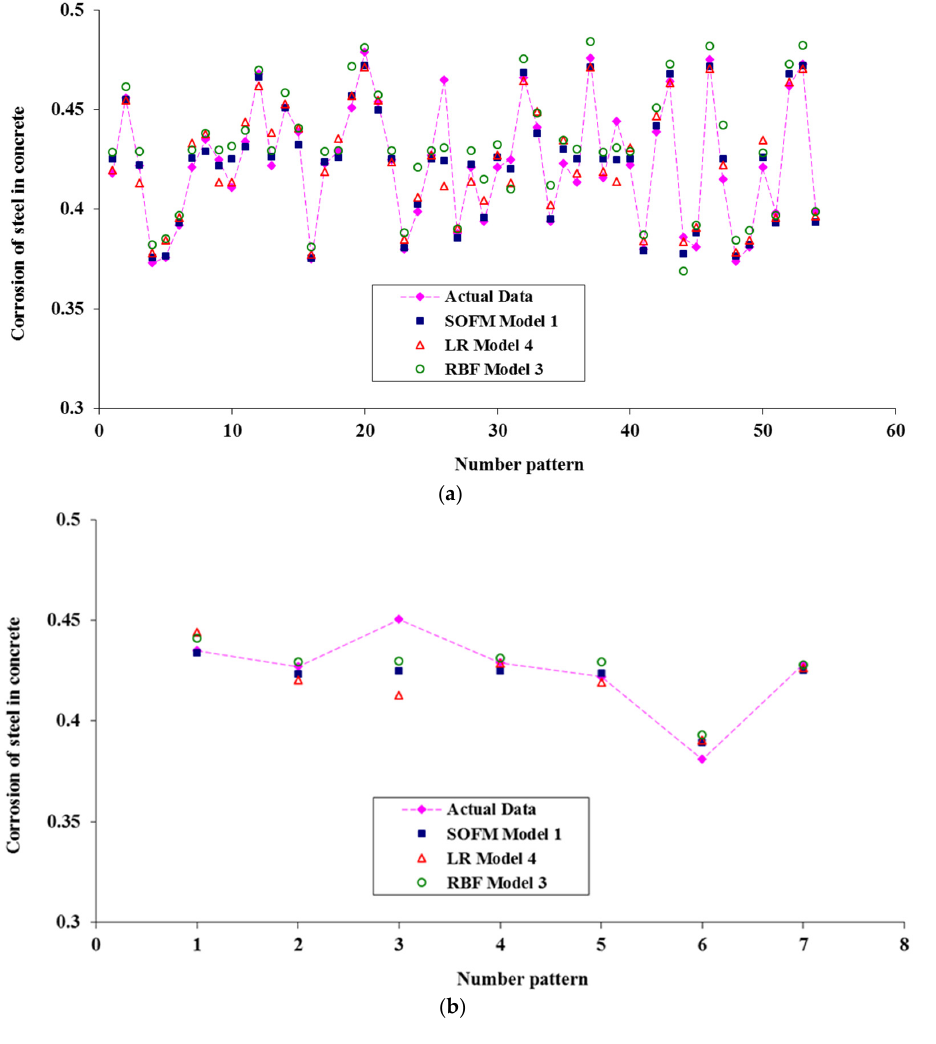
Figure 8. Cont. Figure 8.